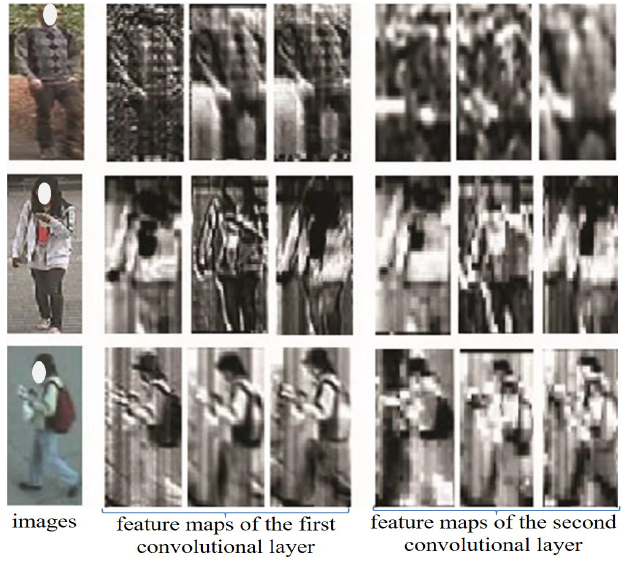
Figure 8. The feature maps of the first and second convolutional